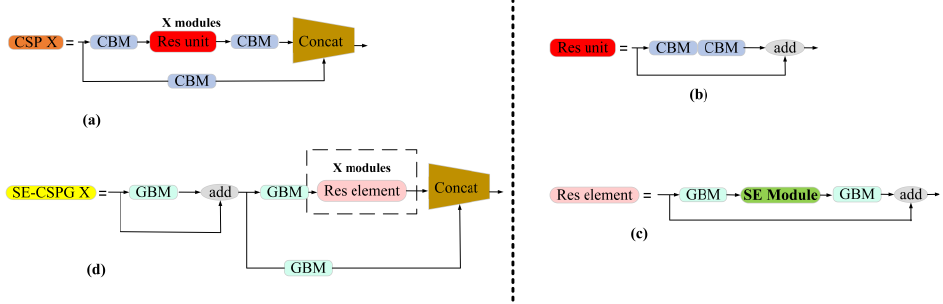
Figure 8. ( a ) CSP structure ( b ) Res unit structure ( c ) SE-CSPG structure ( d ) Res element structure.